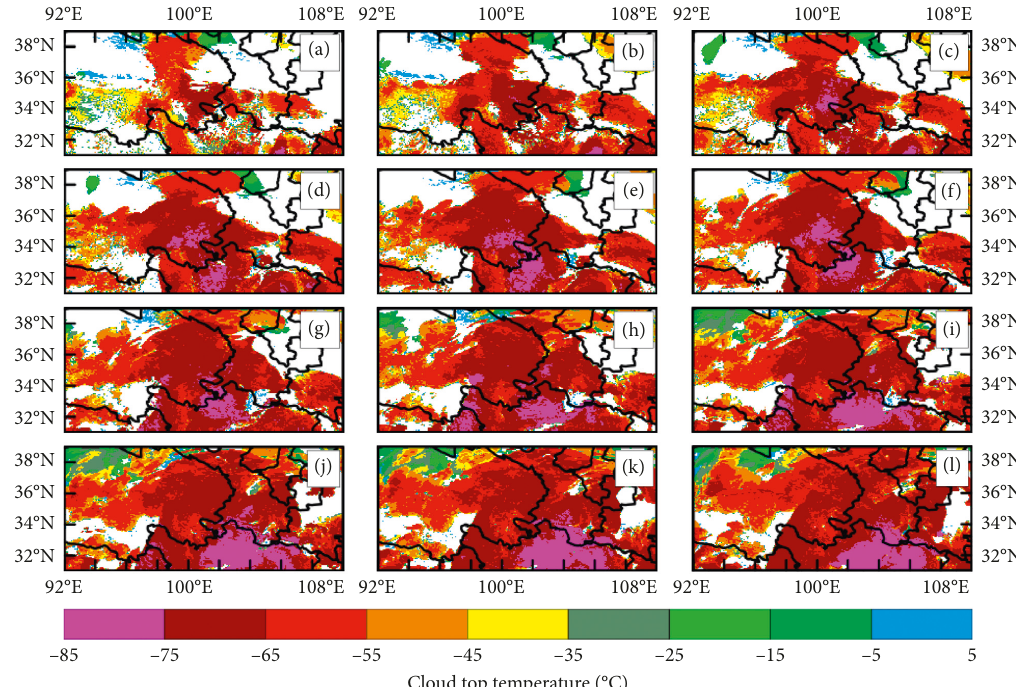
Figure 4: Simulated cloud top temperatures on June 27, 2015 (unit: ° C): (a) 07:00 UTC; (b) 08:00 UTC; (c) 09:00 UTC; (d) 10:00 UTC; (e) 11:00 UTC; (f) 12:00 UTC; (g) 13:00 UTC; (h) 14:00 UTC; (i) 15:00 UTC; (j) 16:00 UTC; (k) 17:00 UTC; (l) 18:00